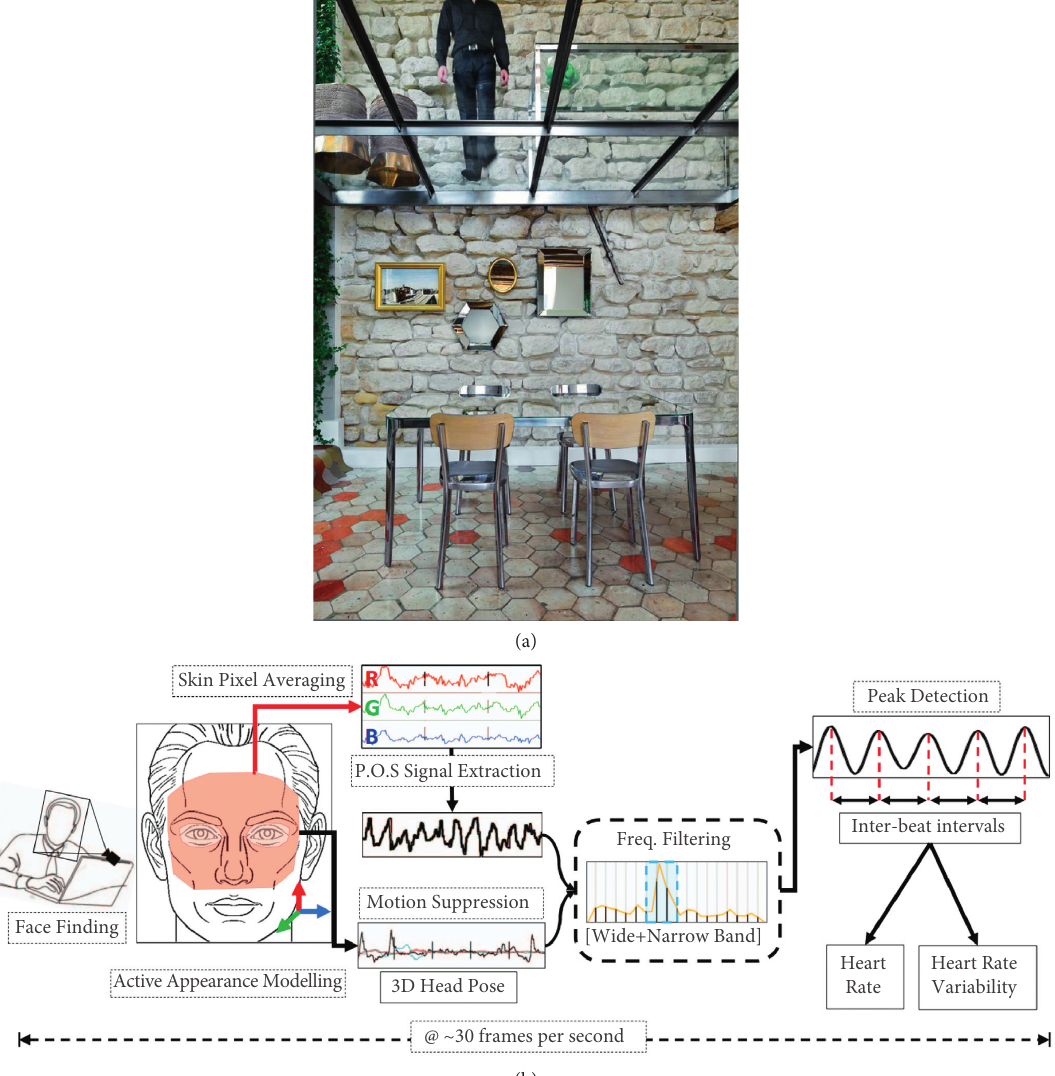
Figure 2: Example of (a) glass structure used as input stimulus (apartment floor in Paris, FR, ©Jerry Jacobs Design) and (b) remote facial expression